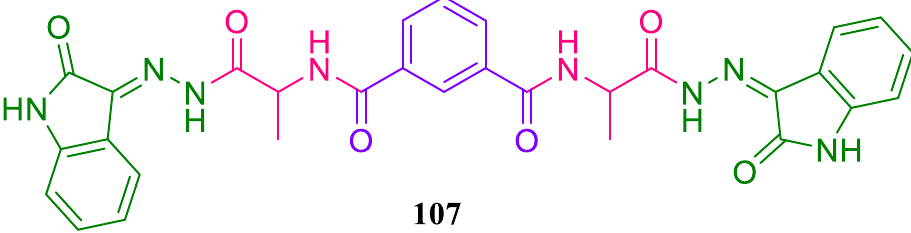
Figure 87. N 1 ,N 3 - bis -(1-oxopropan-2-yl) isophthalamide-based